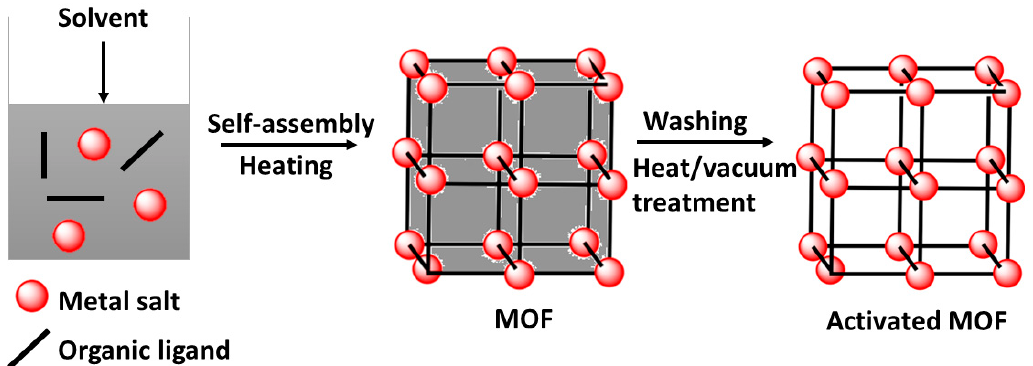
Figure 6. Solvothermal synthesis of